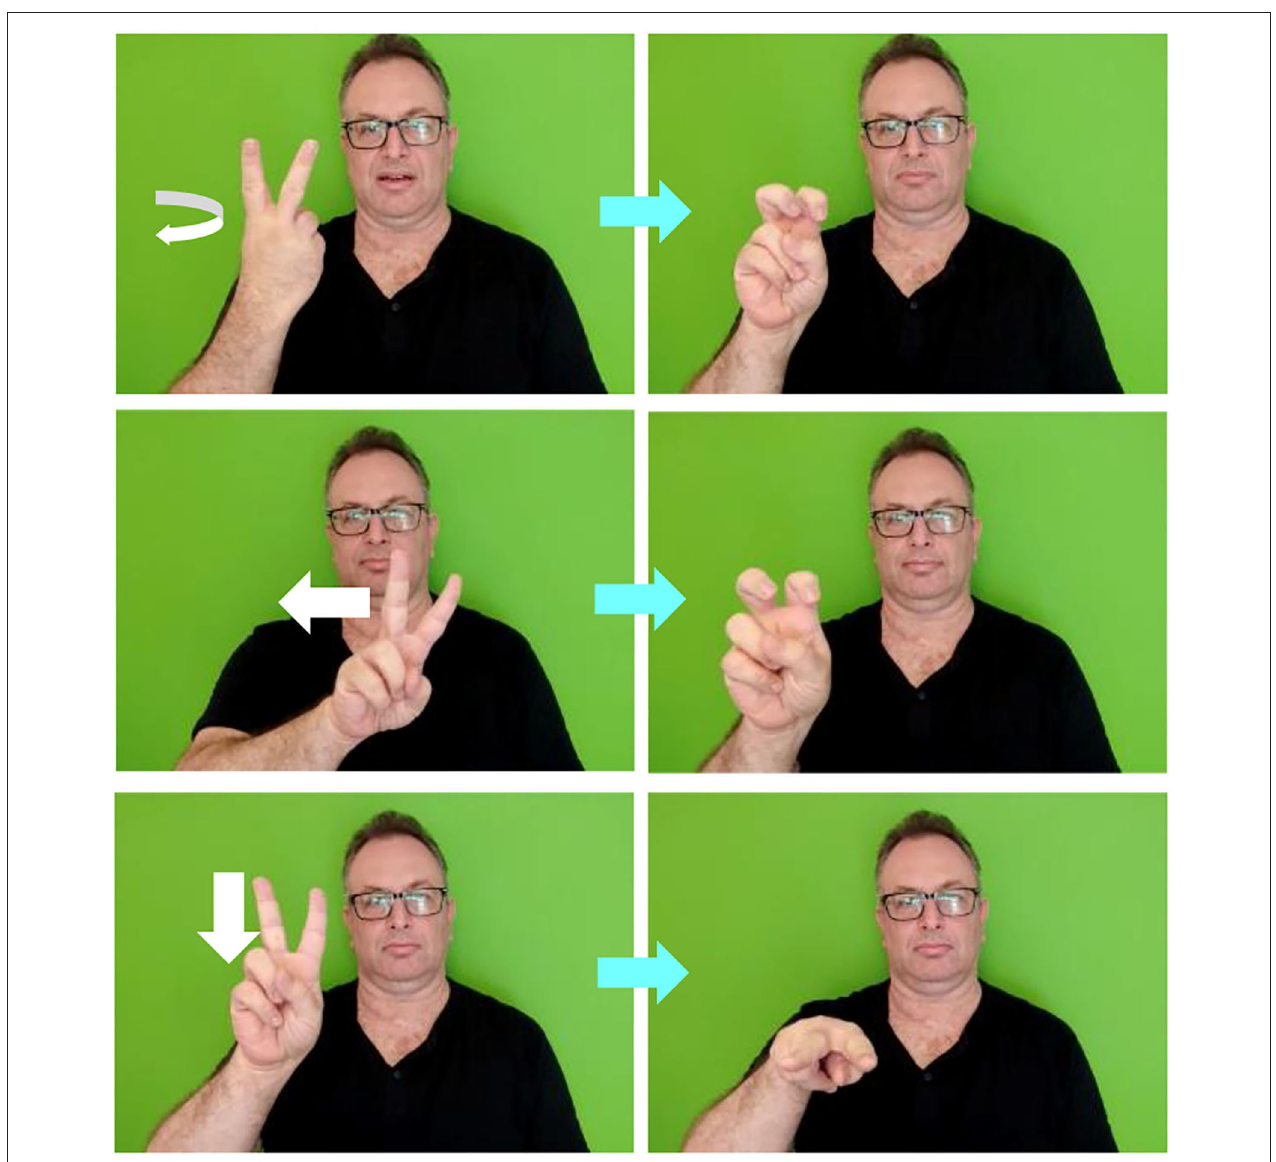
FIGURE 3 | Decimal number-signs in ISL. Top: TWENTY , middle: TWO-HUNDRED , bottom: TWO-THOUSAND . (To see the videos, click the arrows).